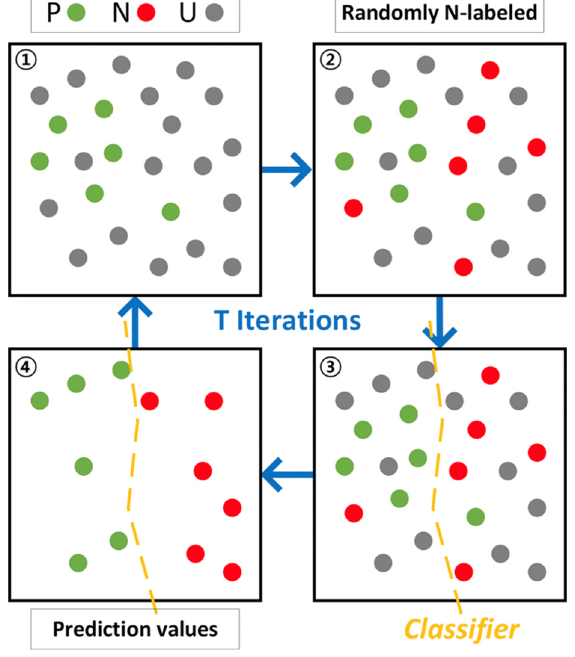
Figure 3. Schematic diagram of positive and unlabeled learning, reprinted with the permission from [43].